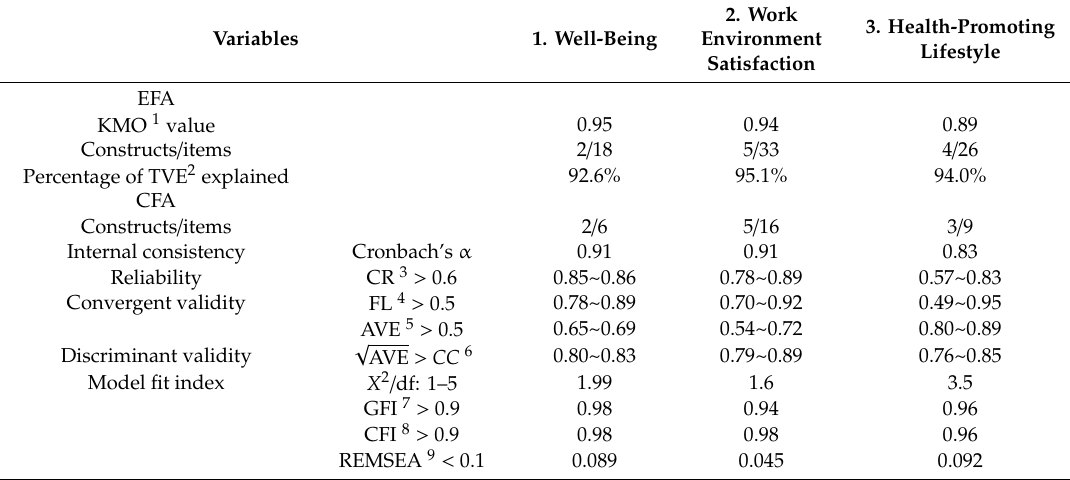
Table 2. EFA and CFA Results for the NHJS Scale.